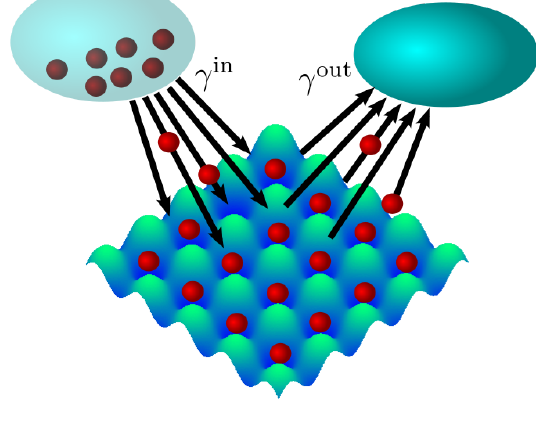
Figure 1: Schematic depiction of a possible realization of the system considered in this work: Fermionic atoms (red spheres) occupy an optical lattice. The lattice is engineered to suppress ordinary tunneling. Instead, the system is connected (e.g., optically) to reservoirs (elliptic blobs) by local couplings (black arrows). The reser- voirs exchange atoms with the system and drive it towards a steady state with specific properties, such as being topologically